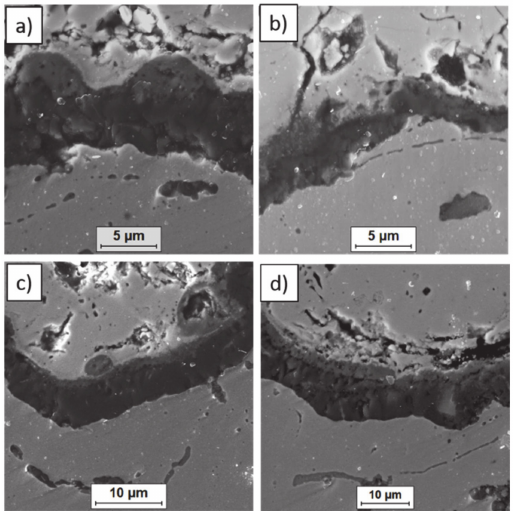
Figure 14. Ceramic layer / bond-coat interfaces of the TBC systems after 500 h of oxidation at a temperature of 1100 ◦ C—monolayered La 2 Zr 2 O 7 TBC (SEM): ( a , b ) zone of the bond-coat top and ( c , d ) zone of the bond-coat bottom.